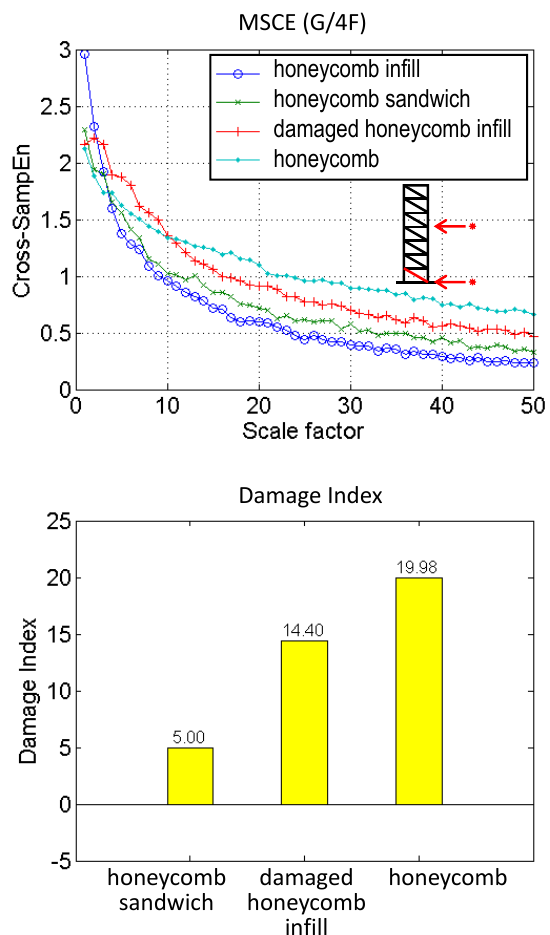
Figure 7. MSCE and DI diagrams of composite structure.